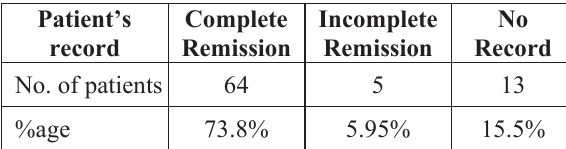
Table-2: Remission status of ALL patients